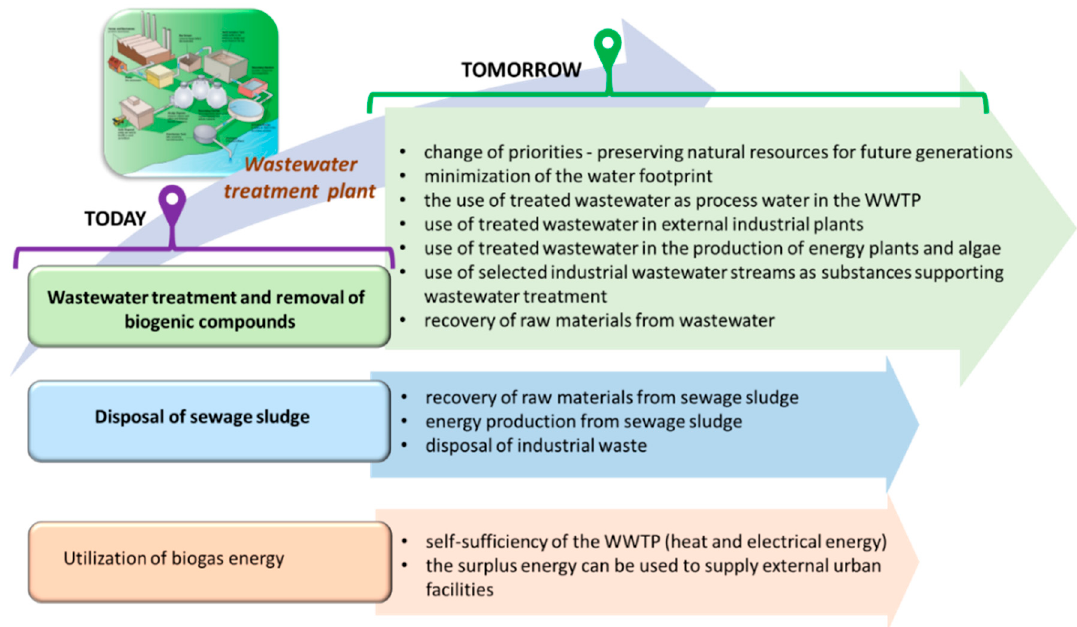
Figure 1. WWTP today and in the future.